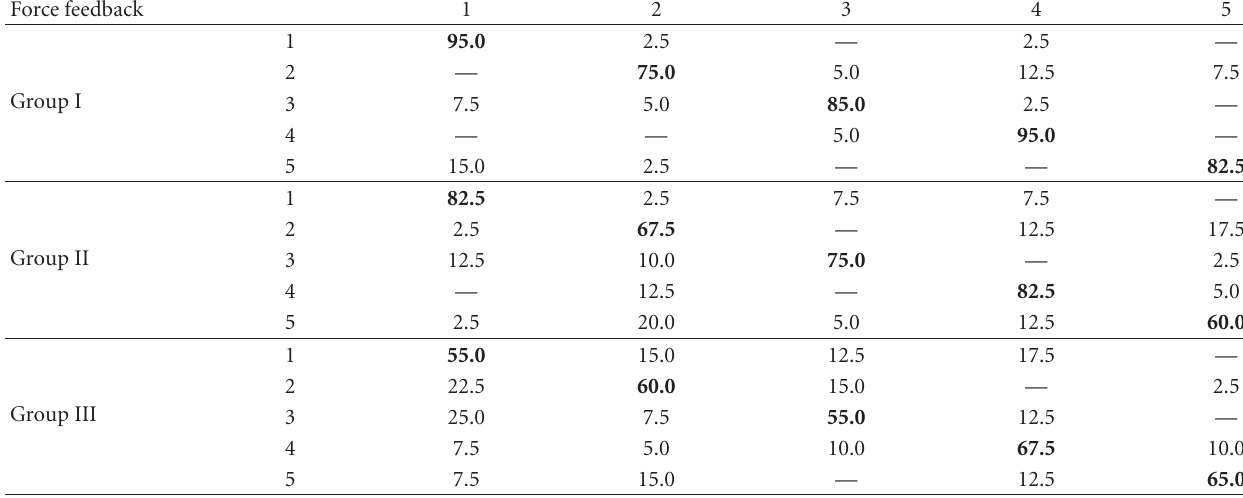
Table 4: Experimental results for force feedback (%).